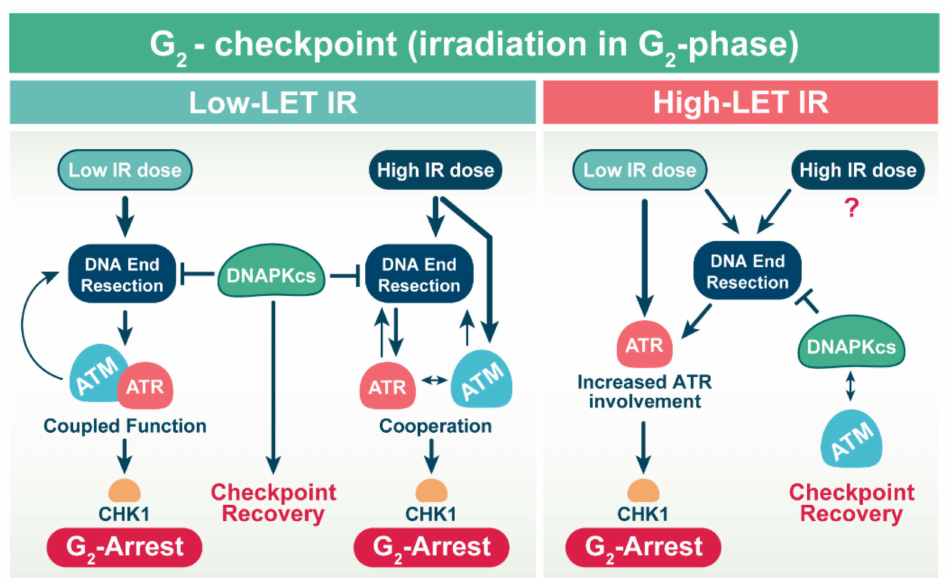
Figure 3. Activation of DNA damage checkpoint in cells irradiated in G 2 -phase of the cell cycle. Exposure of cells to high-LET IR suppresses the repair of DSBs by c-NHEJ, which is associated with increased DNA end resection. Elevated DNA end resection activates ATR that now mainly regulates the G 2 checkpoint (see text for